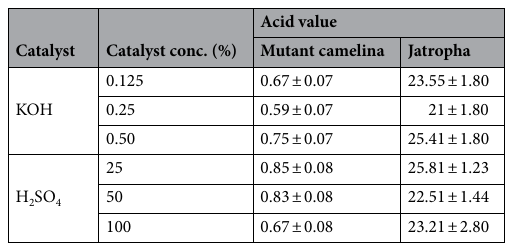
Table 6. Acid value of biodiesel produced from mutant camelina and jatropha.